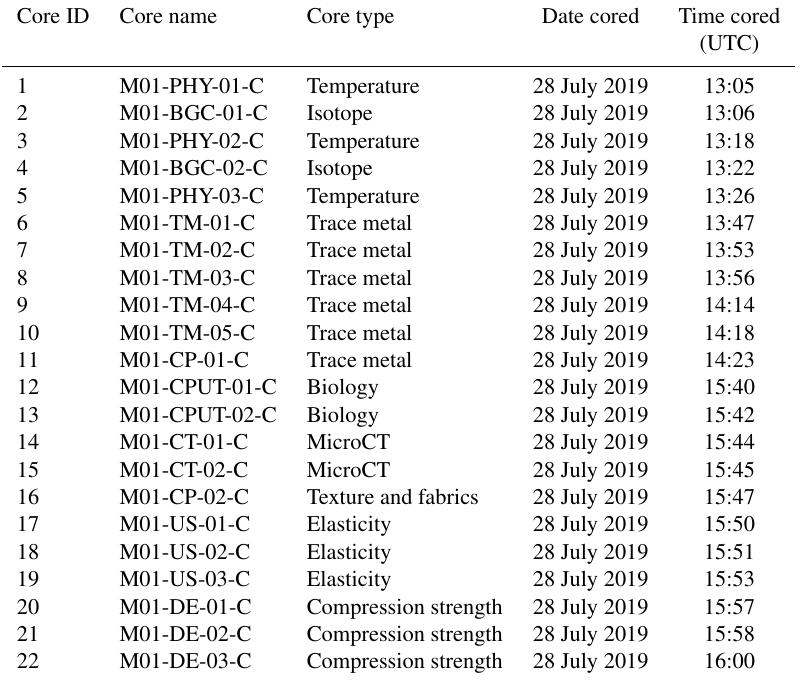
Table A4. Overview of core IDs of Pancake C, corresponding core names, testing designation, and date and time when